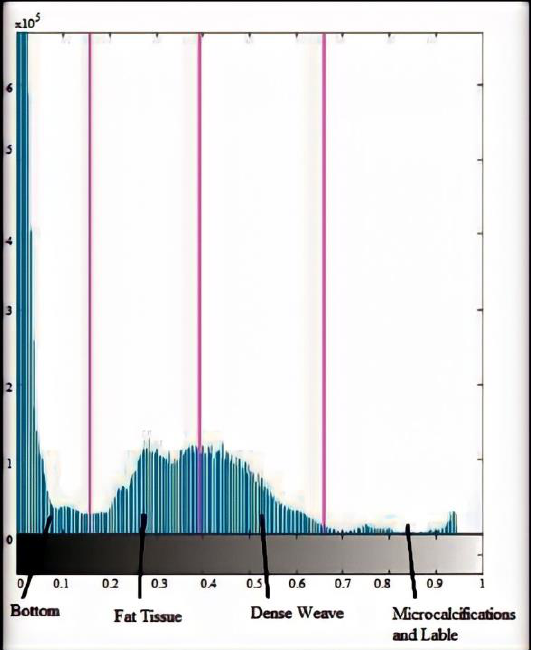
Figure 4. Histograms of mammograms in CC ( a ) and MLO ( b ) views.